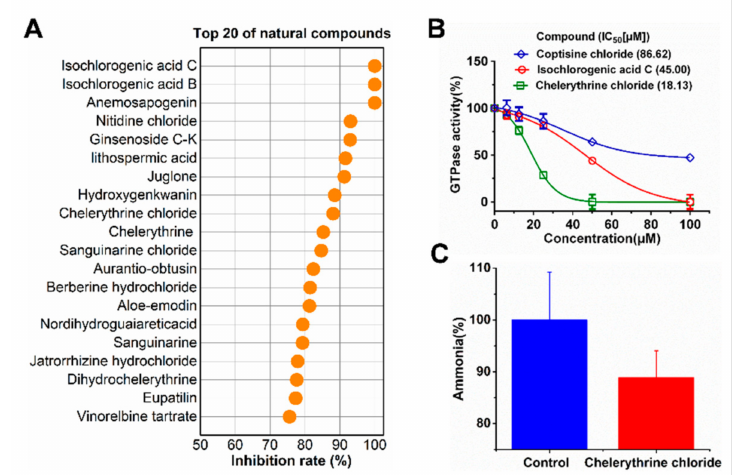
Figure 1. Effect of natural compounds on GTPase activity of UreG and ammonia emission. ( A ) Inhibition rates of the top 20 natural compounds on UreG GTPase activity. In this process, 100 µ M natural compound was added to GTPase assay buffer (2 mM MgSO 4 , 300 µ M GTP, 200 mM NaCl, 1 mM Tris(2-carboxyethyl)phosphine (TCEP), 10 mM KHCO 3 , 20 µ M NiSO 4 , 20 mM HEPES, pH 7.5) containing 3 µ M UreG. ( B ) Inhibition of GTPase activity of UreG by isochlorogenic acid C and chelerythrine chloride. Coptisine chloride is shown for comparison. The IC 50 values against GTPase activity were calculated at different concentrations of natural compounds (100, 50, 25, 12.5, 6.25, and 0 µ M). Results are desired as means ± SD of triplicate tests. ( C ) Effect of chelerythrine chloride on the ammonia release of ruminal microbial crude protein. The final concentrations of ruminal microbial crude protein and chelerythrine chloride were 176 and 7.8125 µ M,